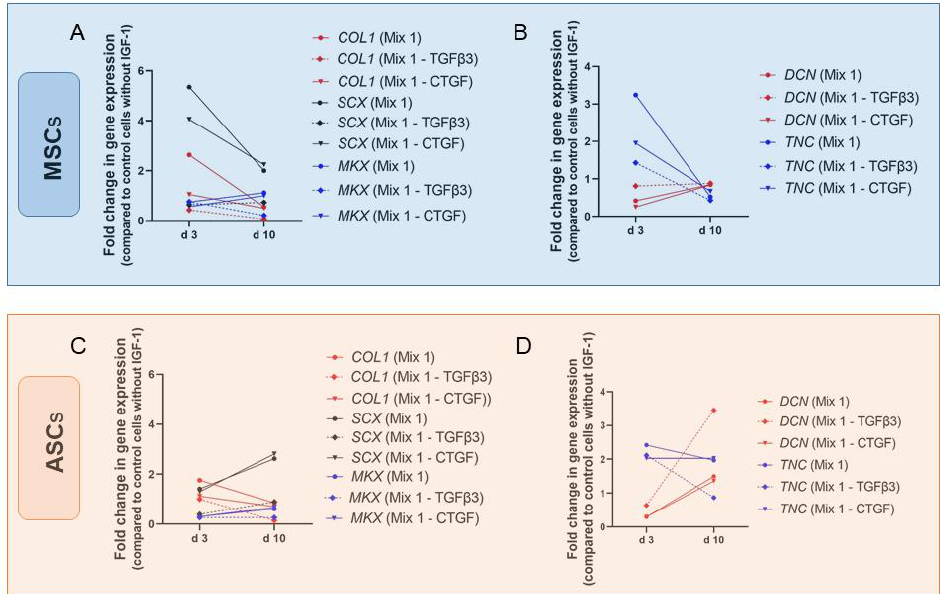
Figure 9. Impact of tenogenic media on the gene expression of human ASCs and MSCs. Gene ex- pression of COL1, SCX and MKX for MSCs (A), DNC and TNC for MSCs (B), COL1, SCX and MKX for ASCs (C) and DNC and TNC for ASCs (D) are provided as manifold changes. Key: Mix 1 contains IGF-1 (50 ng/mL), BMP-12 (50 ng/mL), CTGF (100 ng/mL), bFGF (5 ng/mL), TGF β 3 (20 ng/mL), AA (25 µg/mL), and 1% FBS [103].